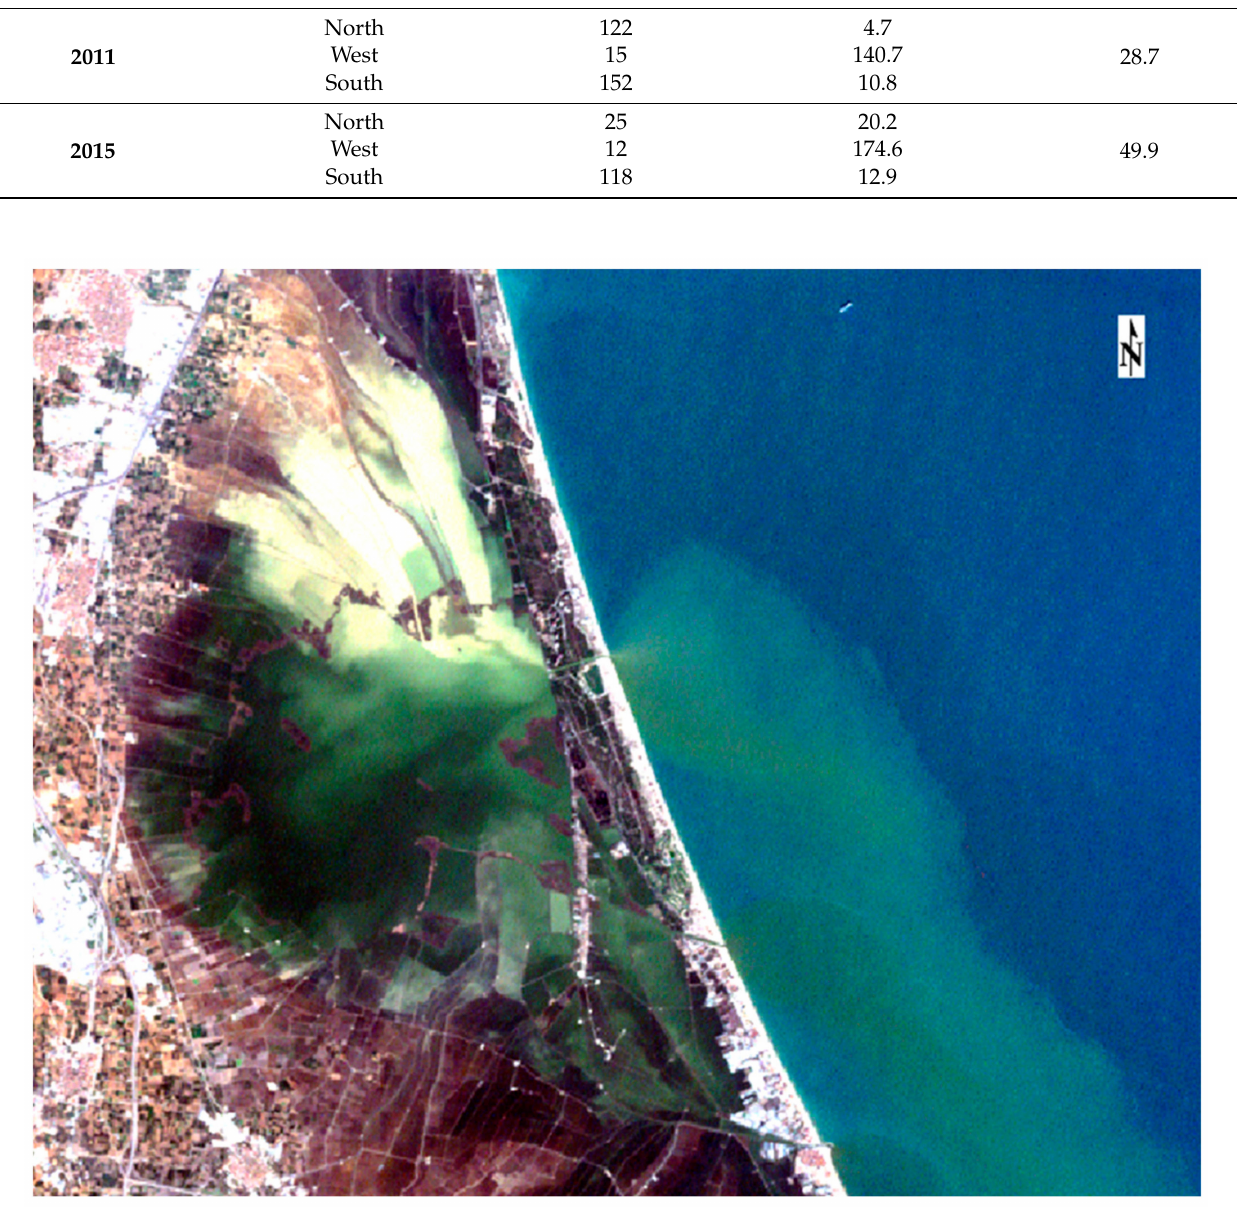
Figure 7. Natural false color image of Landsat 5 from 27 October 2000, showing the contribution of yellowish turbid water through the canals in the northern zone and with less turbidity in the southern zone. It can be seen how the western zone had not these contributions and a renewal zone has been created from the north until the exit to the sea. With less intensity it also happens with the waters of the south